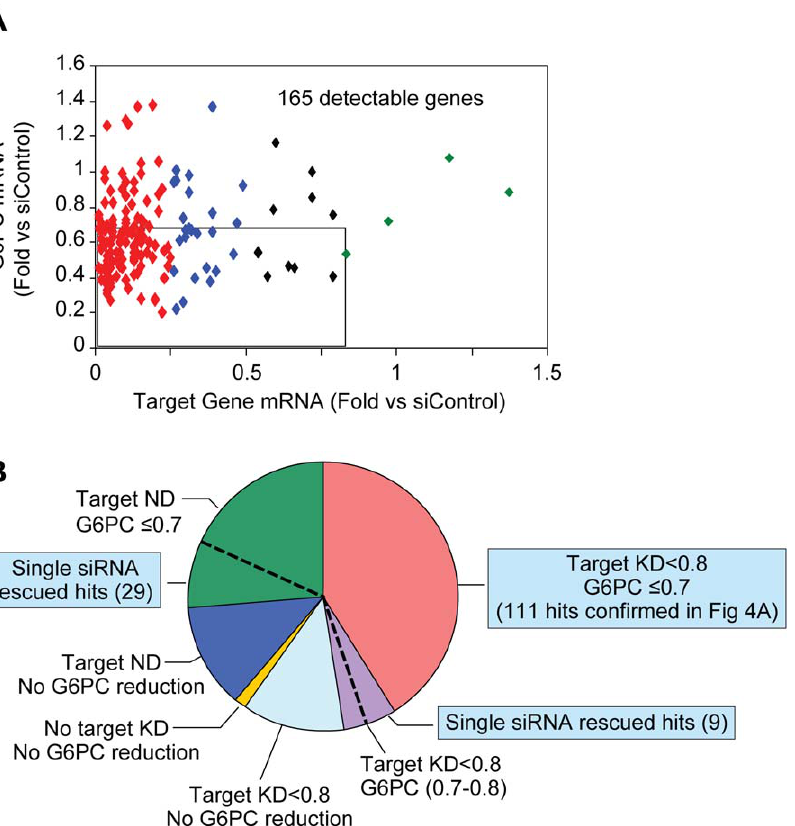
Figure 4. Confirmation of primary screen hits by 2 distinct siRNA assays. A. Pooled siRNA knockdown of 165 Taqman-detectable primary hits vs. reduction of G6PC mRNA expression as determined by Taqman qPCR analysis. Data are shown as fold change compared to mRNA expression in siControl-transfected cells and are the means of a study performed in triplicate. The square contains 111 primary hits that reduce G6PC and target gene expression by # 0.7- and # 0.8-fold, respectively. Red, blue, black, and green dots represent target gene knockdown by , 0.25-fold, between 0.25-fold to 0.5-fold, between 0.5-fold to 0.8-fold, and no knockdown, respectively. B. Schematic diagram for the 270 primary screen hits separated into different categories after target gene knockdown study. Red represents the 111 hits identified above in A. Blue, orange, and light blue represent primary hits that were not confirmed due to lack of G6PC knockdown. Sets of 7 distinct single siRNAs to each of the 270 primary screen hits were tested for their ability to diminish G6PC expression using the 4-gene HTG platform to quantify mRNA levels. Any target gene for which $ 2 single siRNAs reduced G6PC mRNA was deemed ‘‘rescued’’. This assay rescued 9 primary hits whose siRNA knocked down their target gene mRNA but only reduced G6PC mRNA between 0.7- to 0.8-fold (purple) and 29 primary hits that were undetectable by Taqman analysis in the pooled siRNA confirmation assay described in A, but were detectable using enriched cDNA as describe in the ‘‘Results’’ section (green). The blue squares label the gene subsets that were combined to become our final 149 confirmed hits using the confirmation strategy described here. ND: undetectable by Taqman analysis; KD: knockdown.